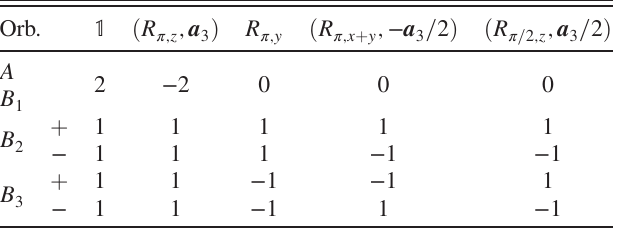
TABLE II. Characters table of the representations of the little group G for k ¼ Z , A . See caption of Table k